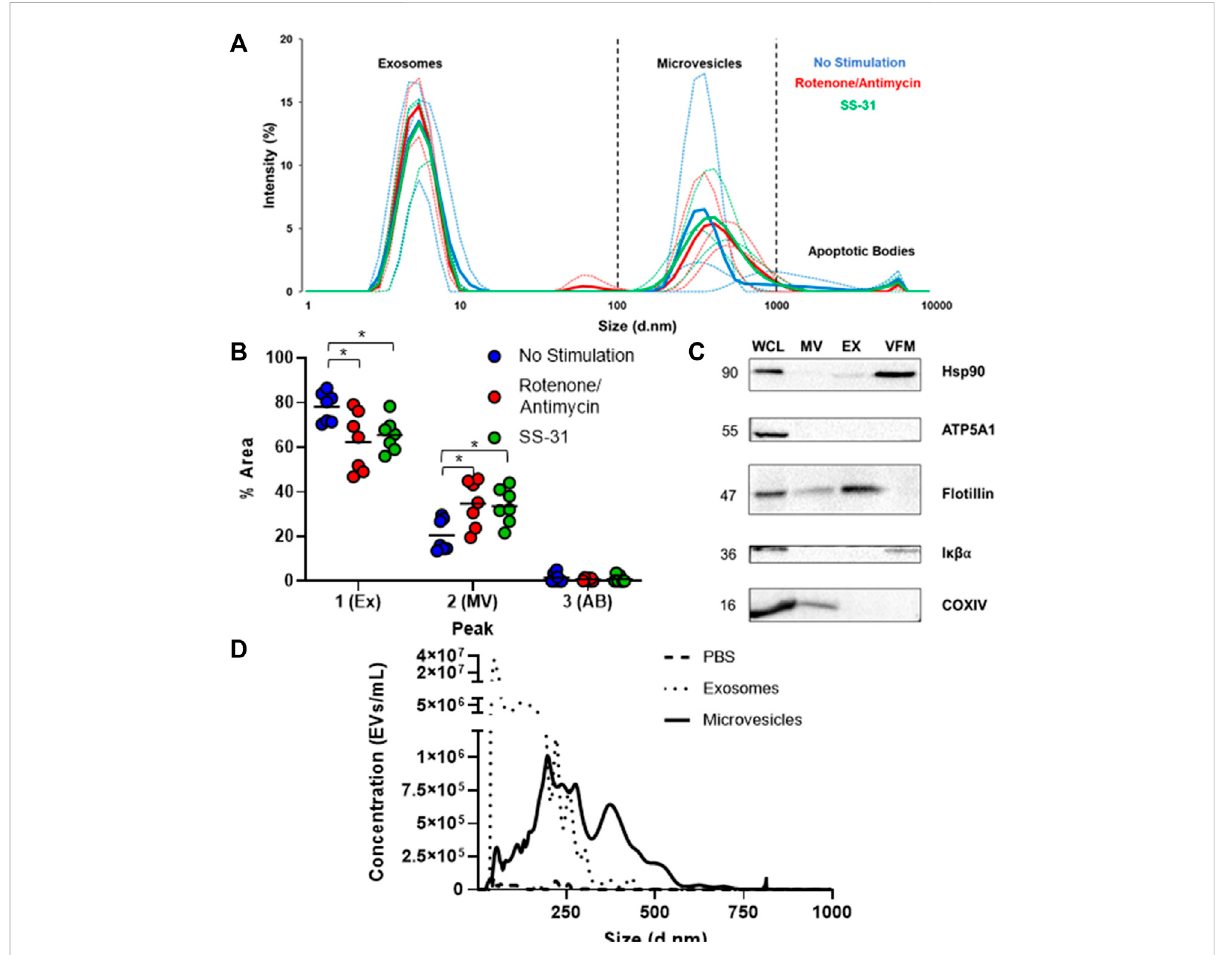
FIGURE 1 Basic characterization of human MSC-derived extracellular vesicles. (A) Dynamic Light Scattering (DLS) of cell-conditioned media (CCM) from murine MSCs revealed three sub-populations of EVs based on size: small, (~5 – 10 nm) medium, (~100 – 1000 nm) and large (5,000 – 10,000 nm), which likely represent exosomes, microvesicles, and apoptotic bodies, respectively. Thin lines represent individual trials ( n = 3), thick lines represent averaged curves. (B) Analysis by one way ANOVA of average percent area under the curve on DLS data revealed a signi fi cantly smaller 1 st (exosome) peak and a signi fi cantly larger 2 nd (microvesicle) peak for both stimulated groups (* = p ≤ 0.05). (C) Immunoblotting of whole cell lysate (WCL)andmicrovesicle(MV),exosome(EX),andvesiclefreemedia(VFM)fractionsofCCM.UbiquitousmarkerHSP90ispresentinWCL,EX,andVFM fractions.TheEVmarker fl otillinispresentinallfractionsexceptVFM,andthecellularmarkerI κ B α isabsentfromexosome(EX)andmicrovesicle(MV) fractions, as expected. MT protein ATP5A1 was found only in WCL, but COXIV (MT) was found in WCL and MVs. (D) Nanoparticle tracking analysis (NTA) of PBS (negative control), EX, and MV fractions indicates that EXs outnumber MVs by several orders of magnitude amongst particles less than 1 μ m, the maximum detection size of